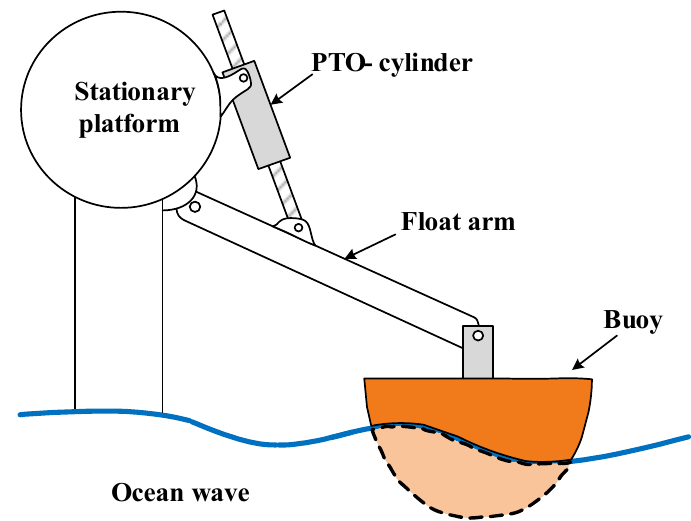
Figure 1. The wave generation system.